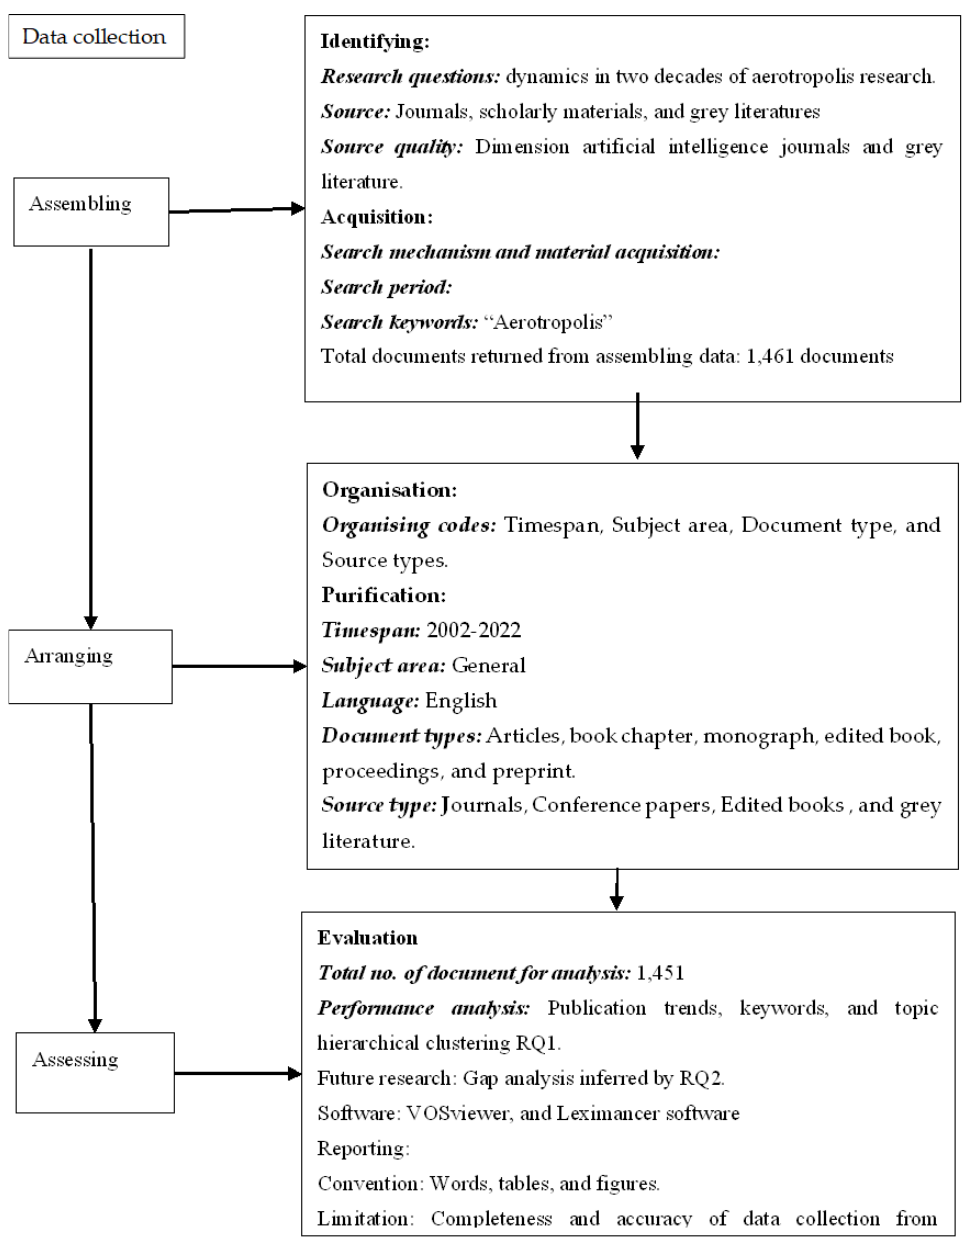
Figure 4 . Protocol for reviewing Aerotropolis using SPAR-4-SLR procedure . Figure 4. Protocol for reviewing Aerotropolis using SPAR-4-SLR